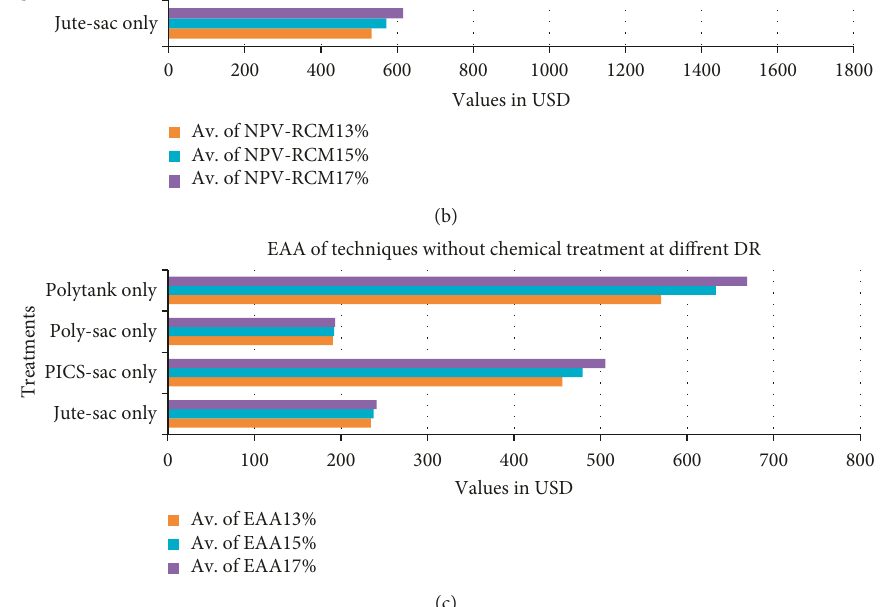
Figure 4: Techniques without treatment NPV, NPV-RCM, and EAA at different